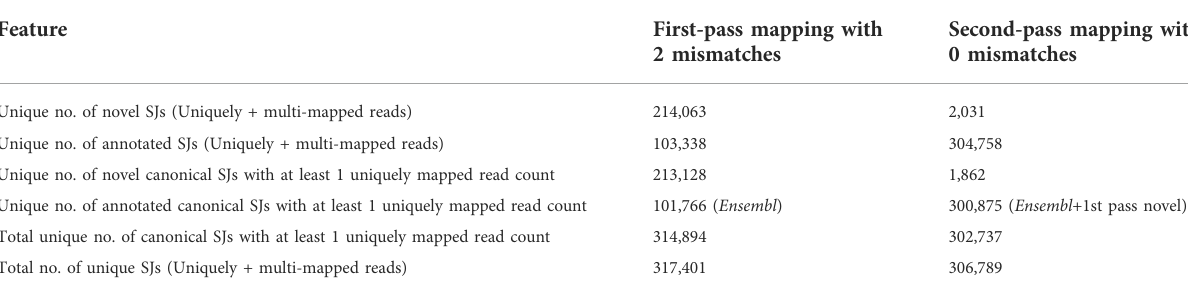
TABLE 1 STAR fi rst and second-pass mapping splice junction (SJ) statistics. RNA-seq clean reads were mapped on the Oryza sativa Indica genome using STAR aligner, which generated the possible SJs. The total number of unique SJs was given with uniquely and multi-mapped reads crossing the SJs. The numbers of both canonical and annotated SJs with at least 1 uniquely mapped read crossing the junction are given. STAR alignment splice junctions (SJs) statistics Feature First-pass mapping with Second-pass mapping with 2 mismatches 0